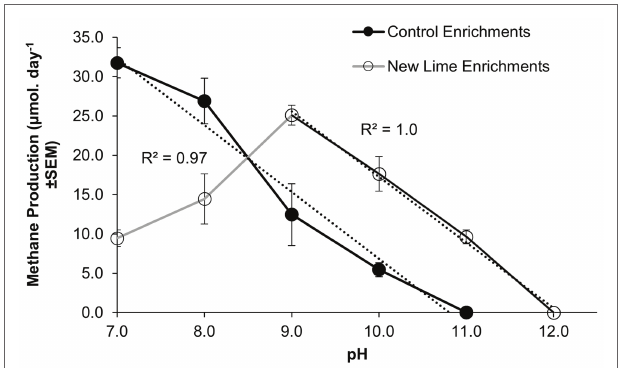
FIGURE 1 | Methane production rates in CDP-fed microcosms employing Control and New Lime sediments operating between pH 7.0 and 12.0. Control microcosms ( n = 2 at all pH values) had a pH optimum of 7.0 ( n = 3), in contrast to the New Lime microcosms ( n = 2 pH 7.0, n = 4 pH 8.0, n = 6 pH 9.0, n = 6 pH 10.0, and n = 2 pH 11.0) were optimal at pH 9.0. The upper pH limit for methanogenesis was pH 10.0 for the Control sediment, and this increased to pH 11.0 in the case of the New Lime sediments. No methane generation was detected at a pH >11.0 (“ n ” denotes the number of replicates